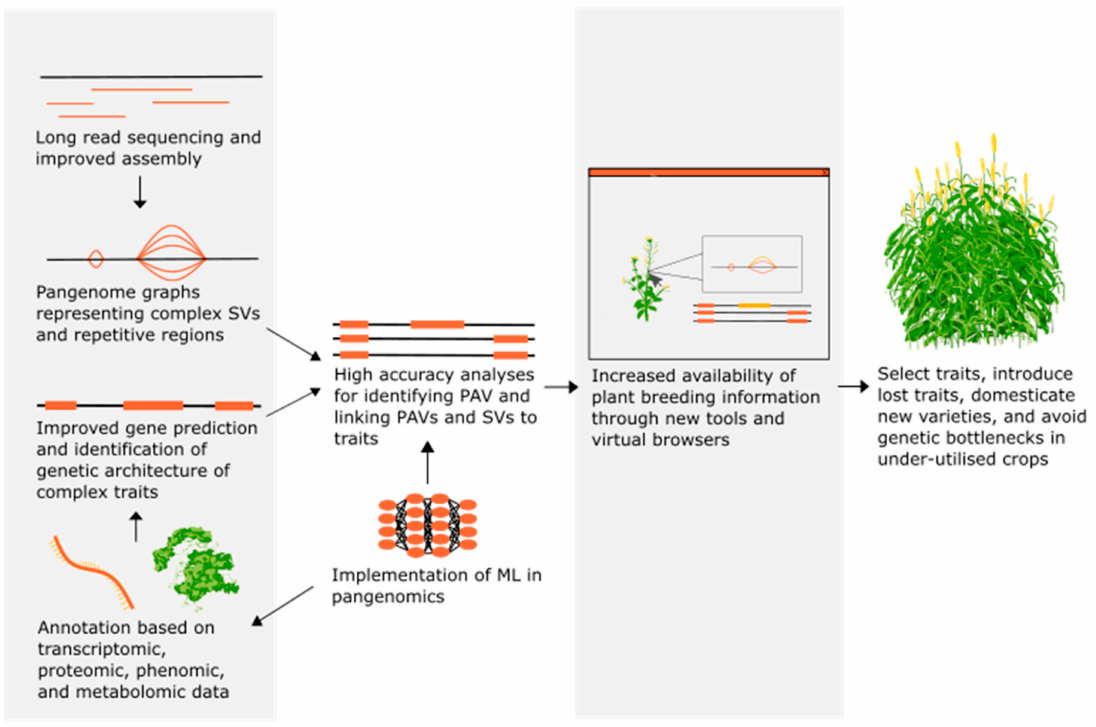
Figure 2. Predicted benefits to plant breeding from future developments in pangenomics. Improve- ments in pangenome assembly and annotation combined with machine learning (ML) technology will increase the accuracy of analyses on gene presence/absence variation (PAV) and structural variation (SV) in different individuals of crop species. These analyses will be available to plant breeders through new tools and browsers, allowing easier selection of traits and genetic diversity in crop